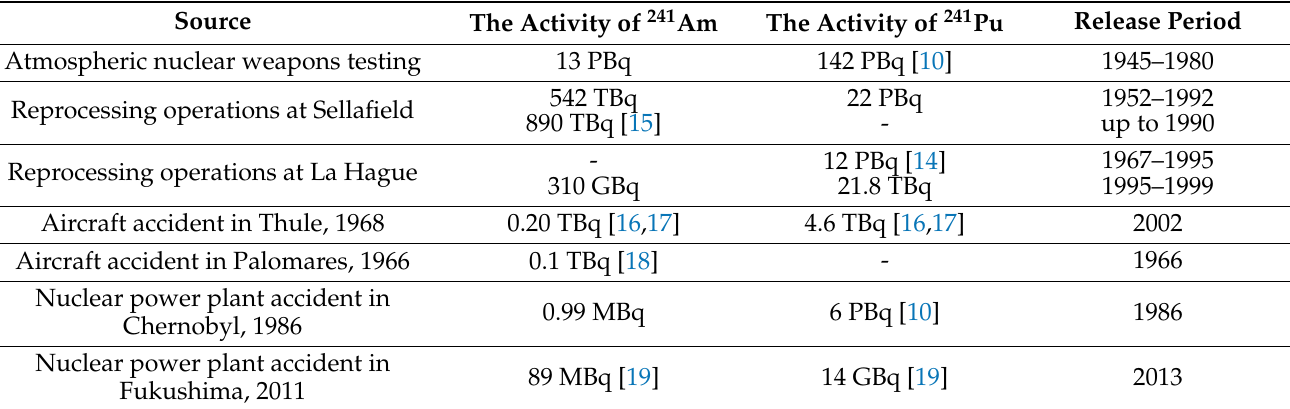
Table 1. Sources of 241 Am and 241 Pu in the